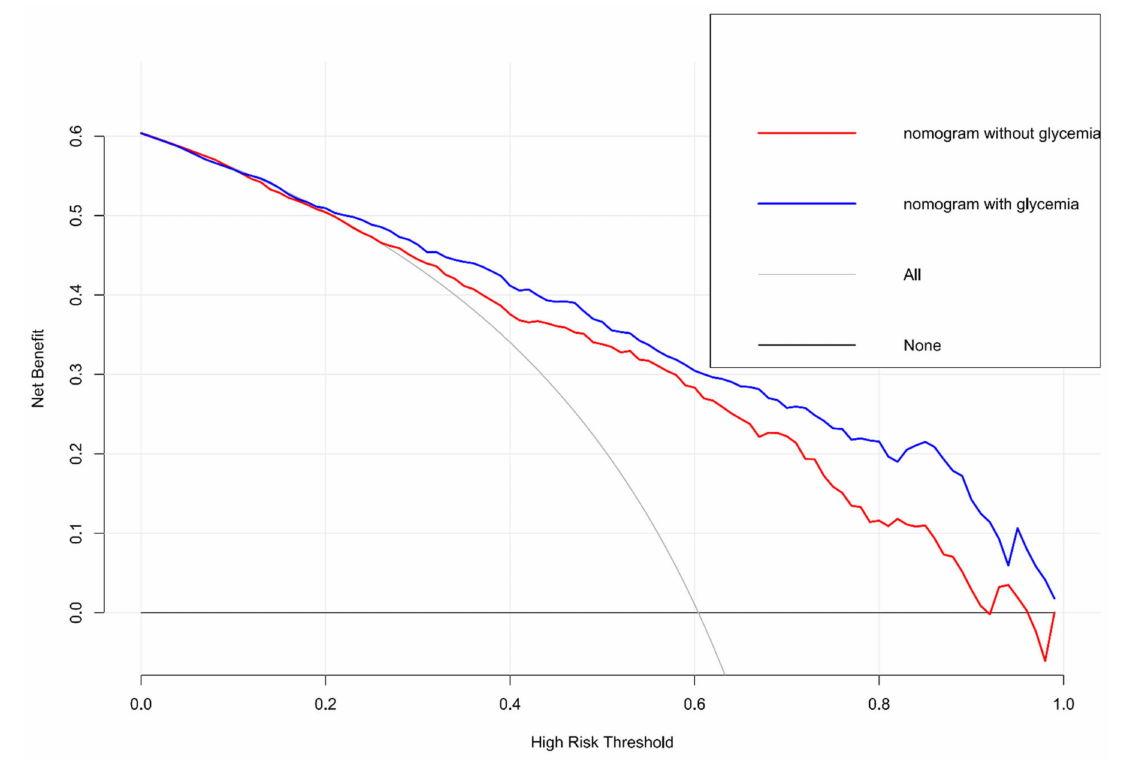
Figure 4. Decision curve analysis for the